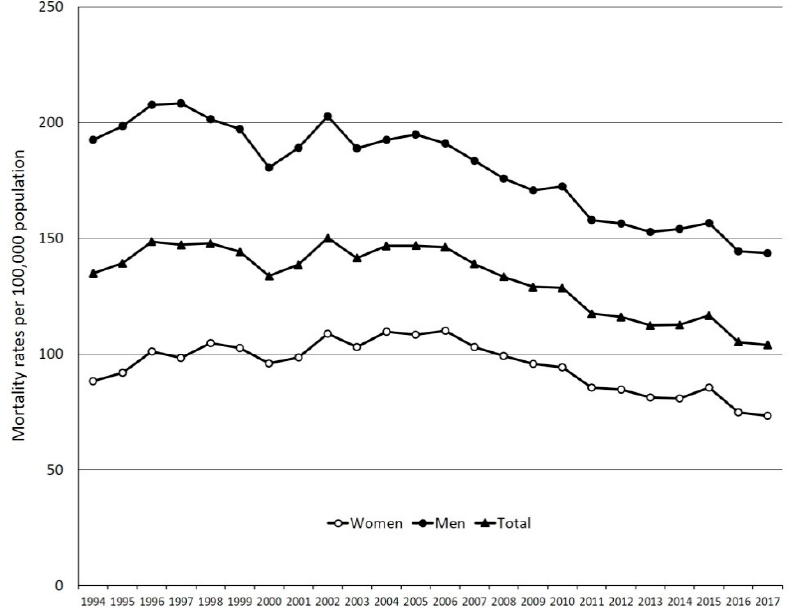
Figure 1. Acute myocardial infarction age-standardized mortality rates in Romania (1994–2017).